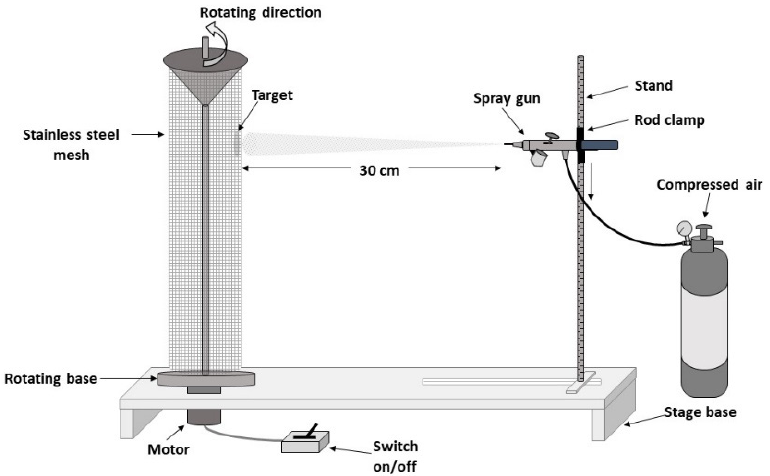
Figure 13. Schematic diagram of the immobilization of the photocatalyst on a stainless steel woven wire mesh cylinder via an air assisted spray coating technique adapted from Lugo-Vega et al. [59]. Using the proposed impregnation method, the photocatalyst coated with immobi- lized photocatalyst on the wire mesh as shown in Figure 14 was obtained. This was achieved with a spray coating efficiency of about 40 wt.%